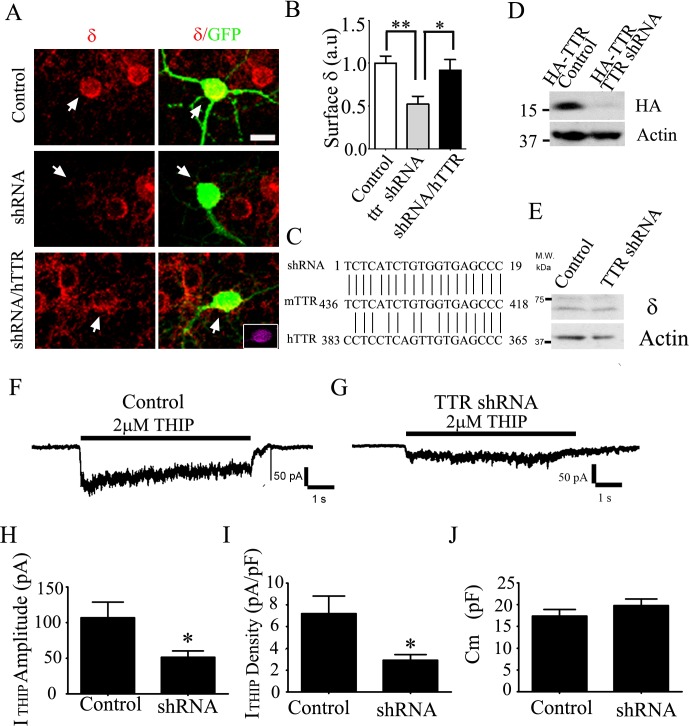
TTR regulates the surface expression of δ-receptors in cultured cerebellar neurons.(A) Knockdown TTR with mouse-specific shRNAs reduced the surface δ-staining (red), which was rescued by co-transection with human TTR (RFP-tagged, purple in the insert) that was resistant to mouse TTR shRNAs. Arrows point to the transfected cells. Scale bar, 10 μm. (B) Quantification of the surface δ staining signal shown in (A). * P < 0.05; ** P < 0.01. (C) Nucleotide sequence alignment showing the specificity of the TTR shRNA designed for mouse TTR, but not for human TTR. (D) Knockdown efficiency of the TTR shRNAs evaluated by cotransfecting mouse HA-TTR with control plasmid or with TTR specific shRNAs in HEK cells. TTR shRNAs significantly downregulated the expression level of mouse HA-TTR. (E) TTR shRNAs had no off-target effect directly on δ-GABAA-Rs when coexpressed in HEK cells. (F-G) Representative traces of THIP current recorded from cultured cerebellar granule cells either transfected with GFP as a control (F) or with TTR shRNA (G). (H-J) Summarized bar graphs showing the THIP current amplitude (H; Control: 107 ± 25 pA, n = 18; TTR shRNA: 55 ± 12 pA, n = 22; P < 0.05, Students’ t-test.), THIP current density (I; Control: 7.2 ± 1.7 pA/pF, n = 18; TTR shRNA: 2.9 ± 0.6 pA/pF, n = 22; P < 0.05), and membrane capacitance (J; Control: 17.4 ± 4.1 pF, n = 18; TTR shRNA: 19.8 ± 4.2 pF, n = 22; P > 0.2) changes after transfection of TTR shRNAs in cultured cerebellar granule cells. * P < 0.05.